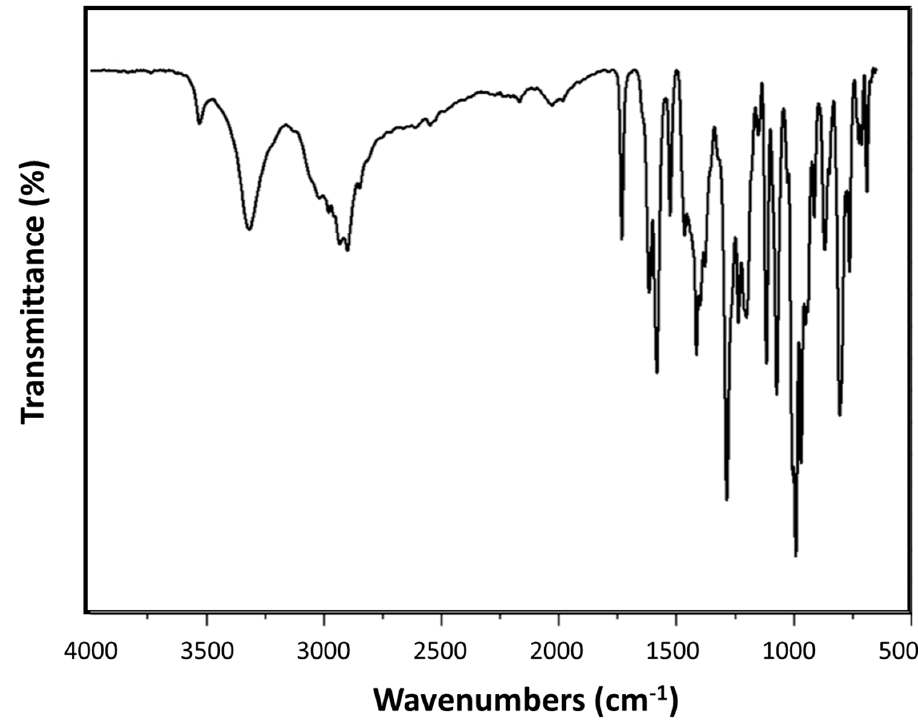
Figure A2. FTIR spectra of doxorubicin detailing a large number of important bands around 1800–500 cm − 1 .